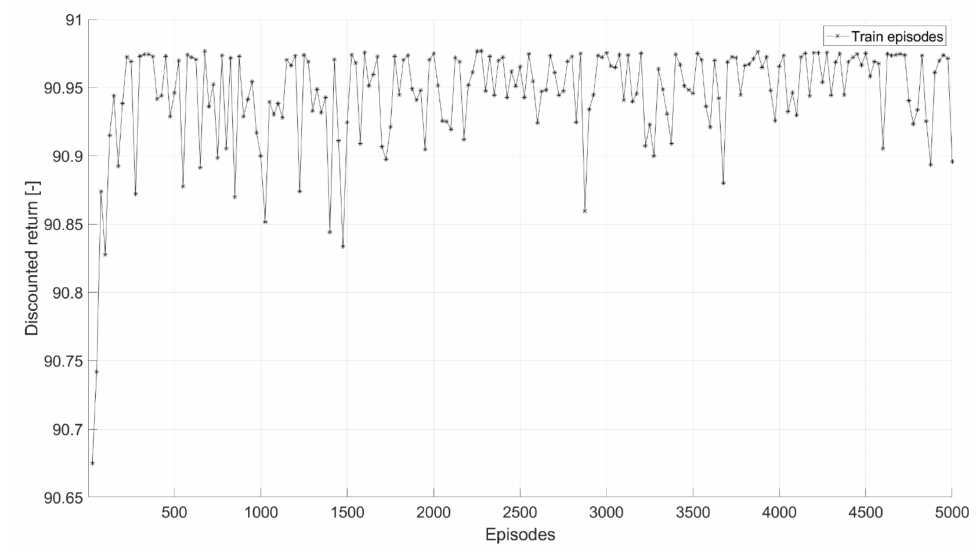
Figure 10. Discounted return of the training episodes calculated at the initial time step of CLUST1 for γ =